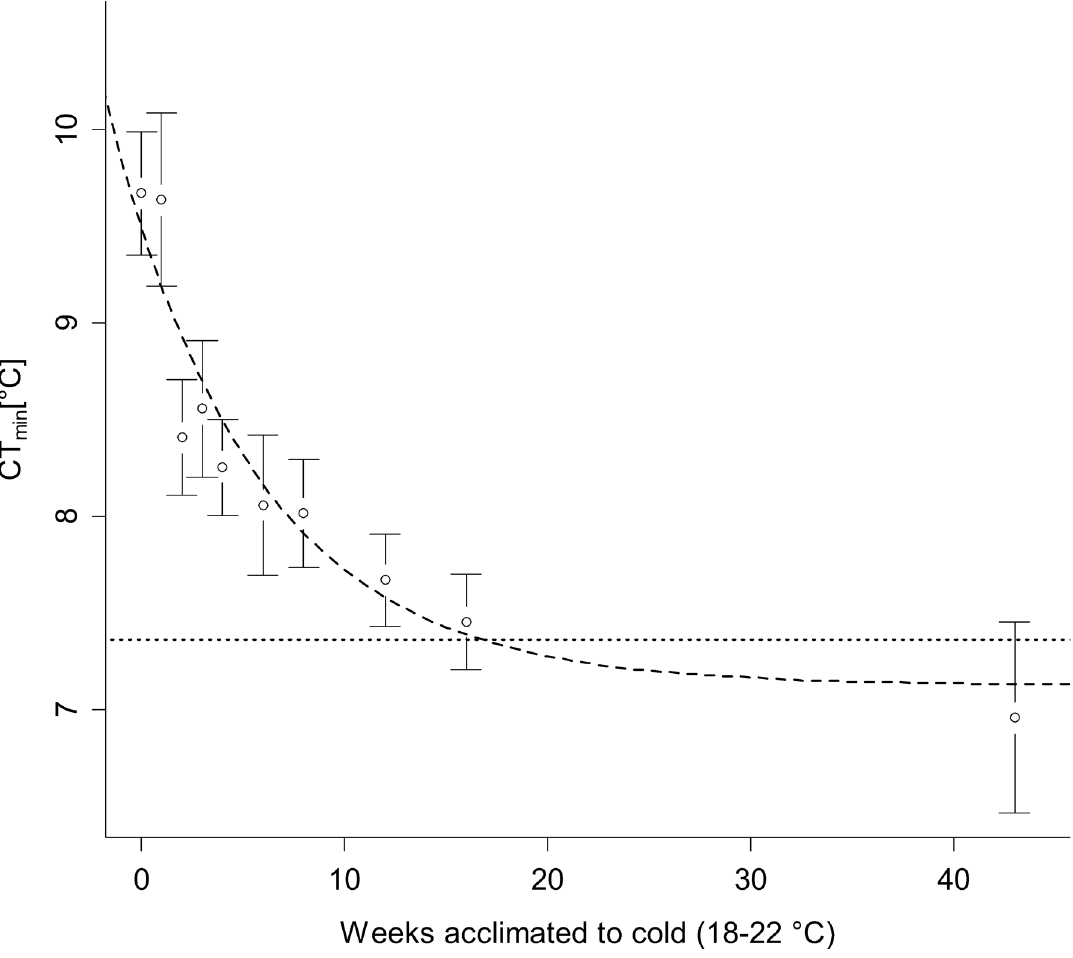
Fig 1. Acclimation of CT min in captive Carlia longipes . Critical thermal minimum temperatures [°C ± 2SE] of captive individuals of Carlia longipes acclimated to a temperature regime of 18 – 22°C for different time periods measured in weeks. Every week, 3 to 4 previously untested individuals were added to the experimental group and other individuals retested. Past 8 weeks acclimation, only previously tested individuals were used. Predictor line for an average sized animal (4.88g) is shown (dashed). Values approach an asymptote of 7.13°C for an average sized animal, with 95% (7.36°C) of this acclimation completed after 17 weeks (dotted